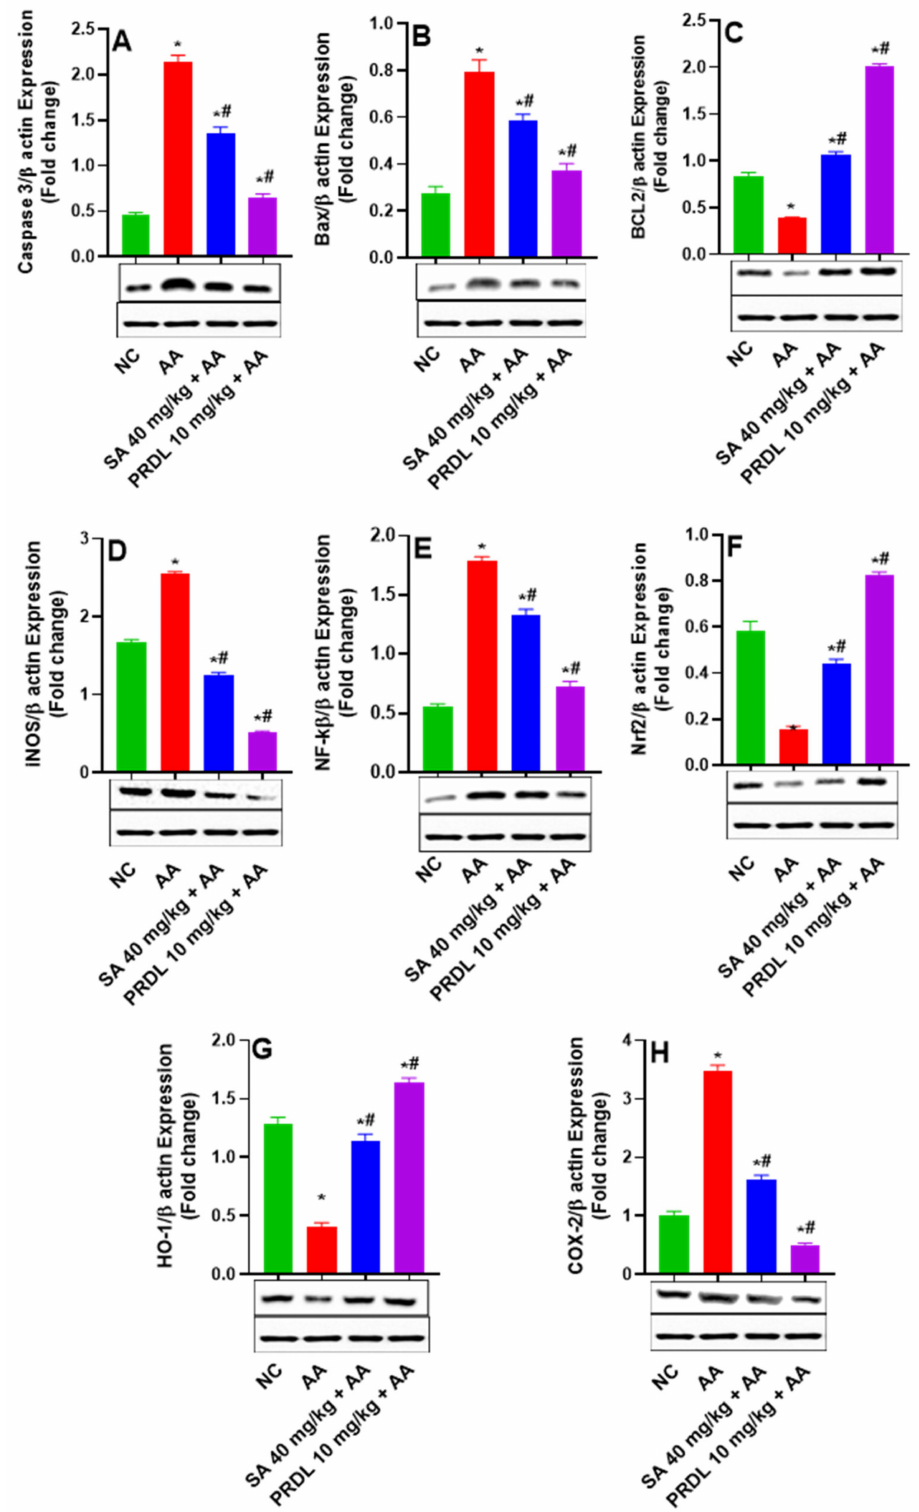
Figure 5. Effects of SA on apoptotic proteins and restoration of antioxidant defense ( A ) Caspase 3, ( B ) Bax, ( C ) BCl 2 ( D ) iNOS, ( E ) NF-kB (p65 heterodimer), ( F ) NRF2, ( G ) HO-1 and ( H ) COX-2 expression levels in AA-induced ulcerative colitis rats. The protein expression was analyzed in colon tissue of all experiment groups. The results are presented as mean ± SEM ( n = 6) per group. * denotes significant differences compared to the control group ( p < 0.05); # denotes significant differences compared to the AA group ( p <